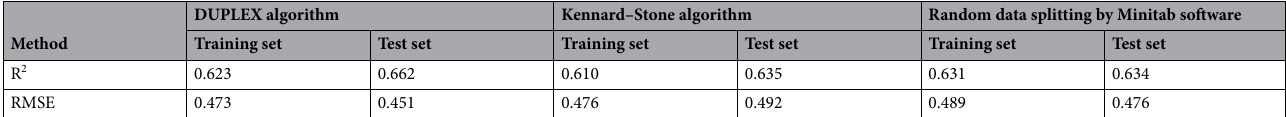
Table 4. Calculated R 2 and RMSE parameters for training and test sets separately, following the data splitting process by three methods.